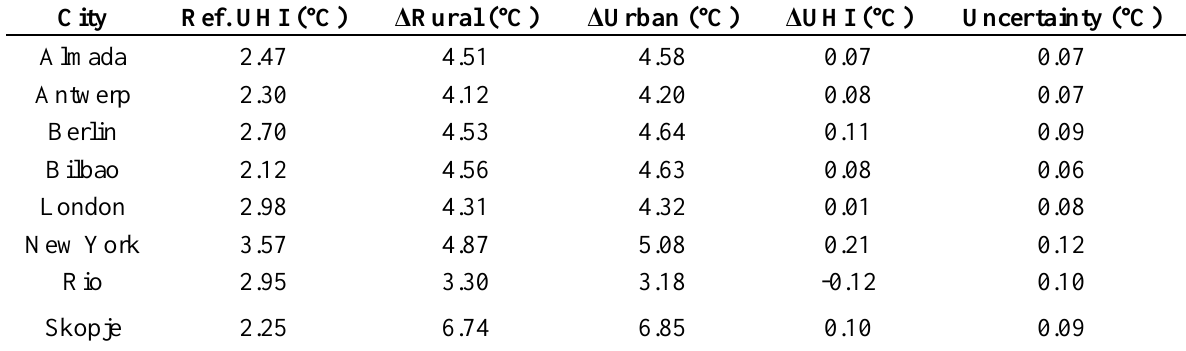
Figure 9. Temperature indicator for Antwerp for the period 2081–2100, based on the 11 GCM-driven simulations. Table 5. Change in the UHI indicator between the reference period (1986–2005) and the end of the century future (2081–2100) under Representative Concentration Pathway (RCP) 8.5 conditions. The rightmost column gives the estimated uncertainty on the change in the UHI